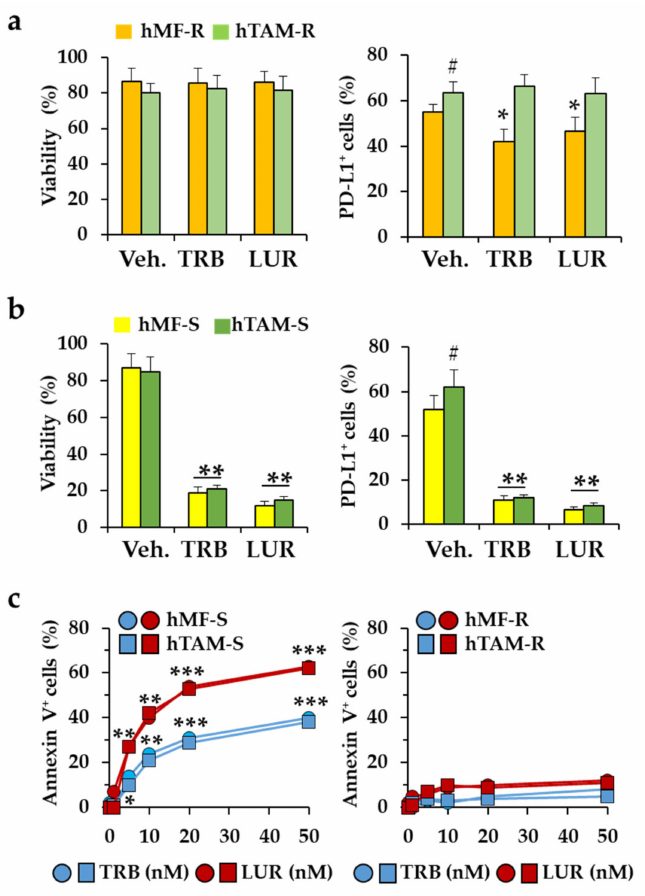
Figure 8. E ff ect of TRB and LUR on viability and cell surface levels of programmed-death ligand 1 (PD-L1) in hMF. ( a ) hMF and hTAM di ff erentiated cells from drug-resistant donors were treated for 24 h with TRB (5 nM) and LUR (1 nM) and the viability and PD-L1 exposure in the cell surface were determined by flow cytometry; ( b ) analysis in TRB and LUR sensitive (hMF-S) cells; ( c ) dose-dependent e ff ect of TRB and LUR on annexin V exposure of hMFs and hTAMs from hMF-R and hMF-S healthy donors. Results show the means + S.E.M. of 8 independent preparations of cells. * p < 0.05; ** p < 0.01; *** p < 0.005 vs. the vehicle (Veh.) condition; # p < 0.05 vs. the hMF corresponding condition.